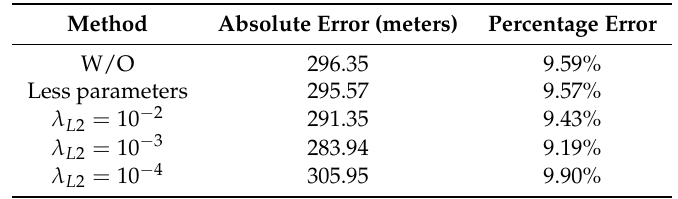
Table 2. Absolute (in meters) error and percentage error with respect to the total range of no regularization (W/O), L2 regularization ( λ L 2 ) and diminished capacity (Less parameters) on test error of the satellite-imagery dataset. Note that the global maximum for the dataset was 3016 and the minimum − 73. While at first glance the errors appear large, one has to take into consideration the fact that no ground truth elevation is provided to the model at inference time, so a added constant that does not alter the relative configuration of the terrain can result in large errors. Therefore, the model is successful in managing to restrict its output to a small range around the actual elevation while also preserving the relative geometry of the terrain. Note that we reduce the number of epochs per run to make several configurations and several runs for each